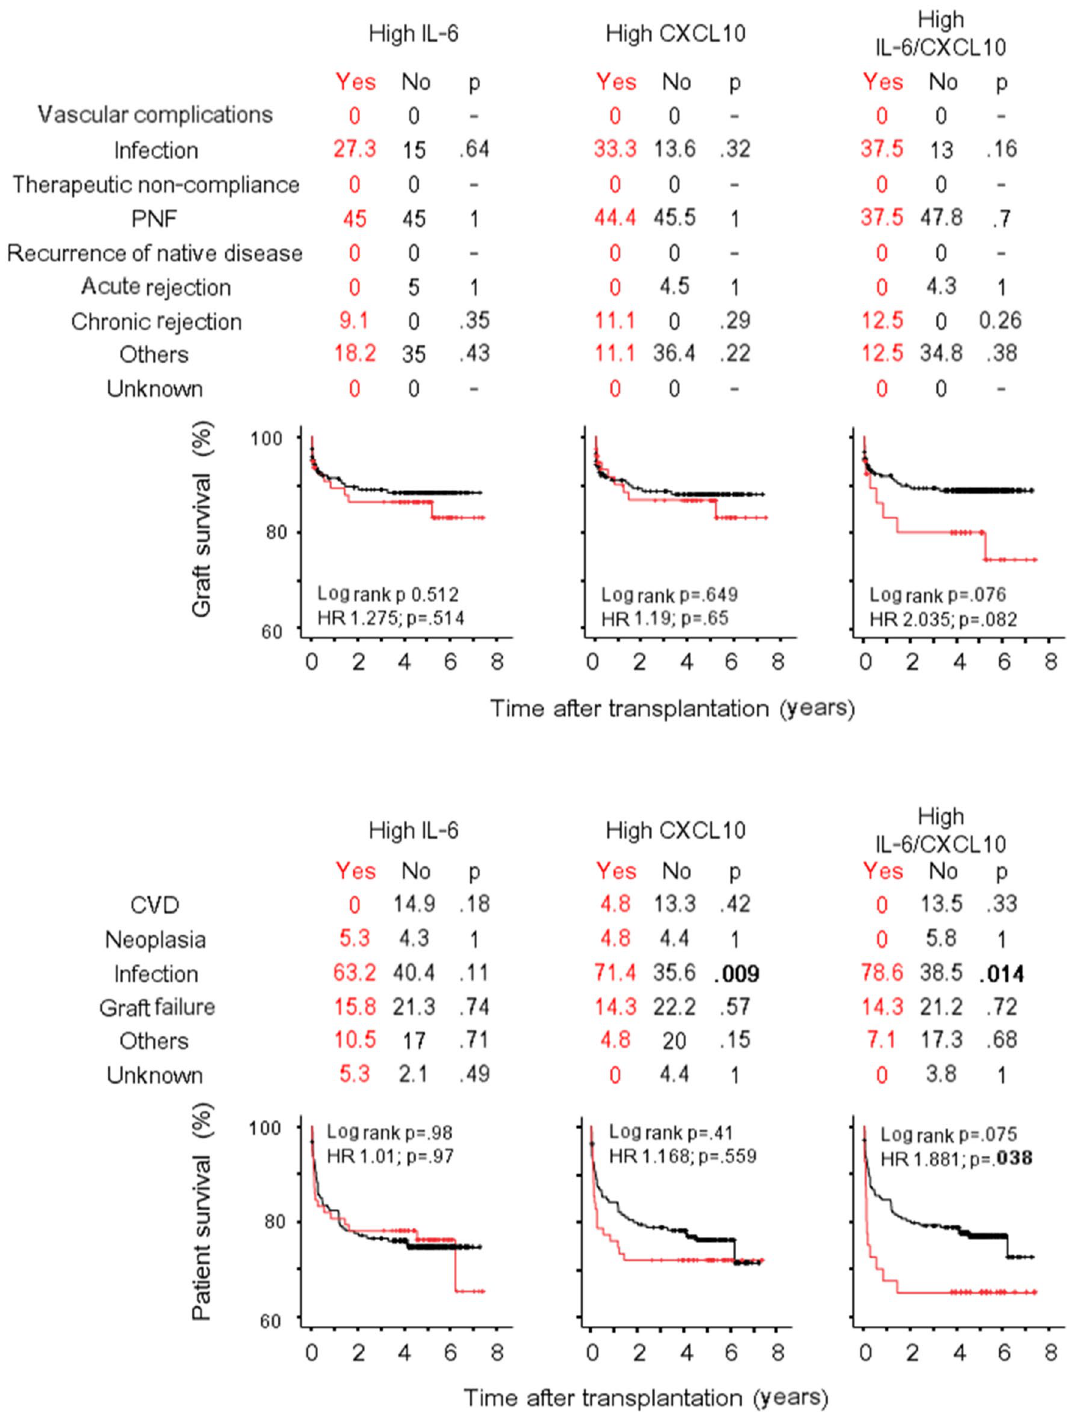
Figure 5. Graft and recipient survival after heart transplantation. Causes of graft failure (%), causes of recipient death (%) and Kaplan–Meier graft and recipient survival curves after heart transplant are represented according to high IL-6 and high CXCL10 categories. PGF primary graft failure, CVD cardiovascular